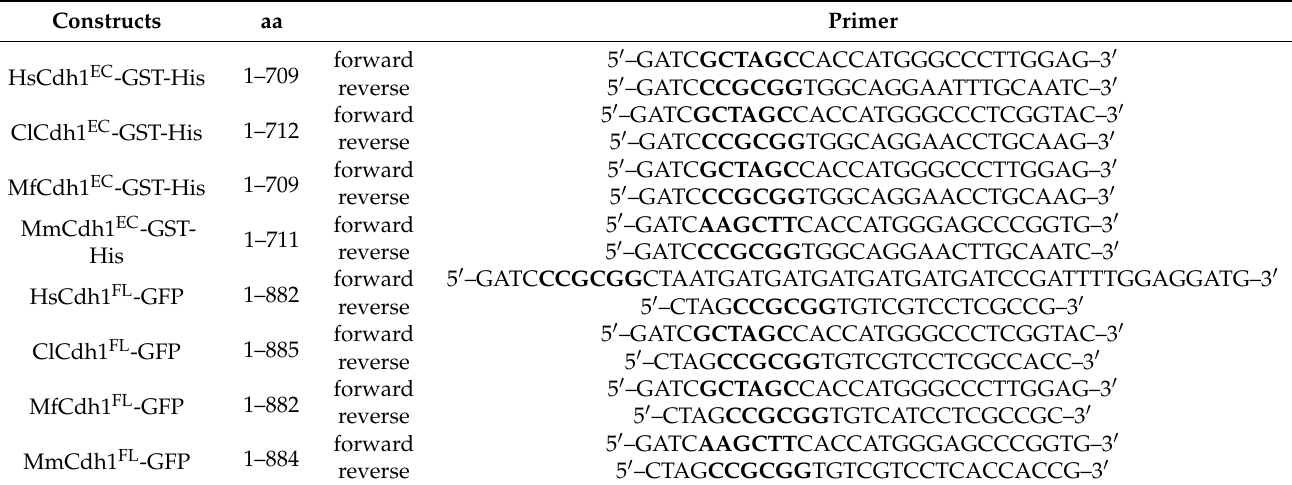
Table 1. Constructs used in the